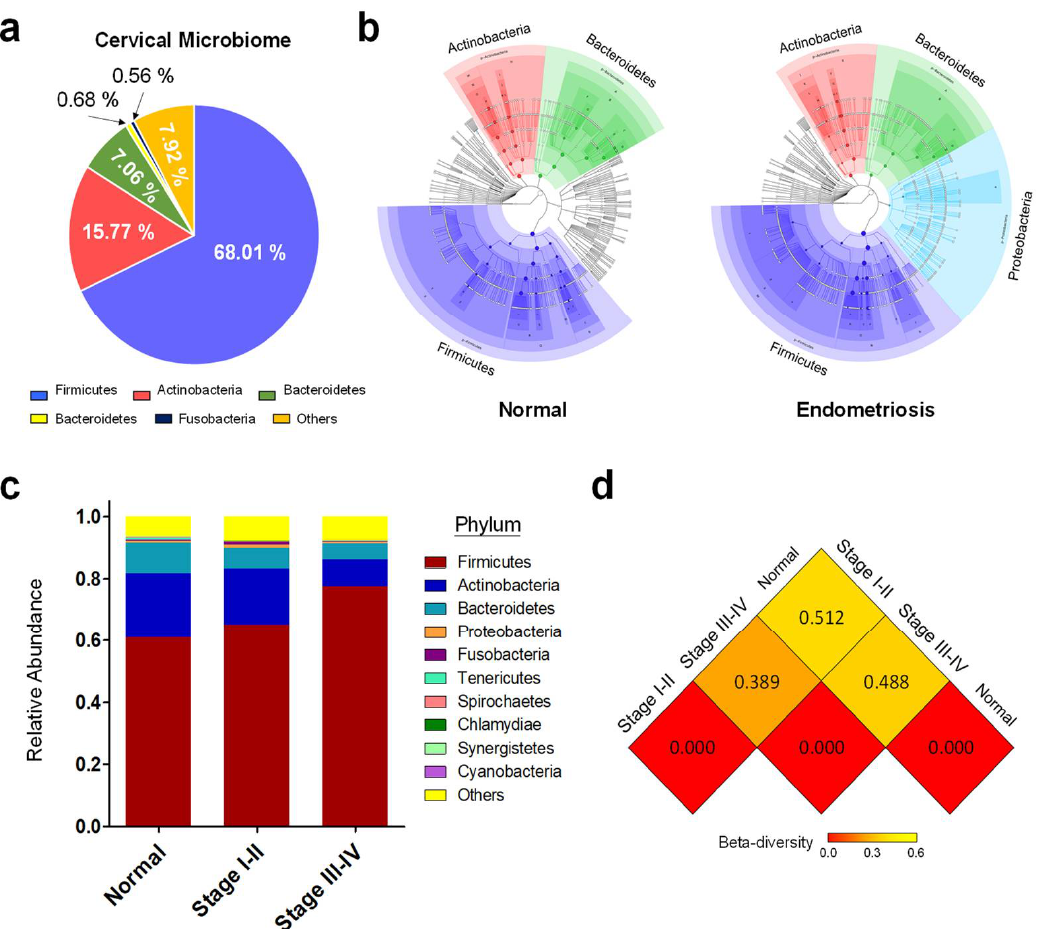
Figure 1. Abundance and composition of cervical microbiomes among normal women and endometriosis patients at different stages. ( a ) The top-5 major phyla of bacteria in cervical microbiome of Taiwanese women. ( b ) Tree graphs of species annotation for cervical microbiomes of normal women and endometriosis patients were constructed and compared by GraPhlAn method. ( c ) Relative abundance of the top-10 major phyla of cervical microbiomes in different groups are shown in distribution histogram. ( d ) Heatmap based on unweighted unifrac distance was plotted to measure the dissimilarity coefficient between pairwise group samples. The three groups include cervical microbiomes from normal women, patients at stage I-II and patients at stage III – IV.